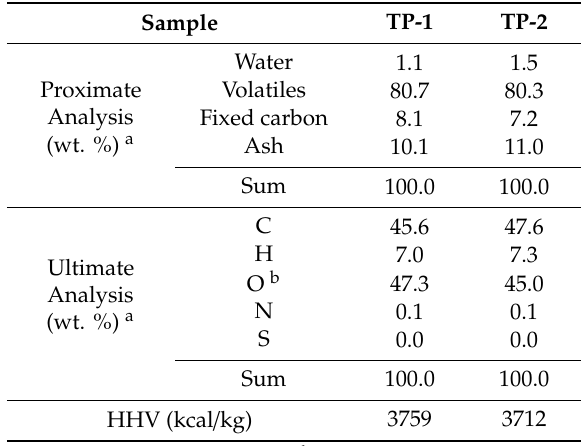
Table 1. Proximate, ultimate, and HHV analysis results of TP-1 and TP-2. Sample